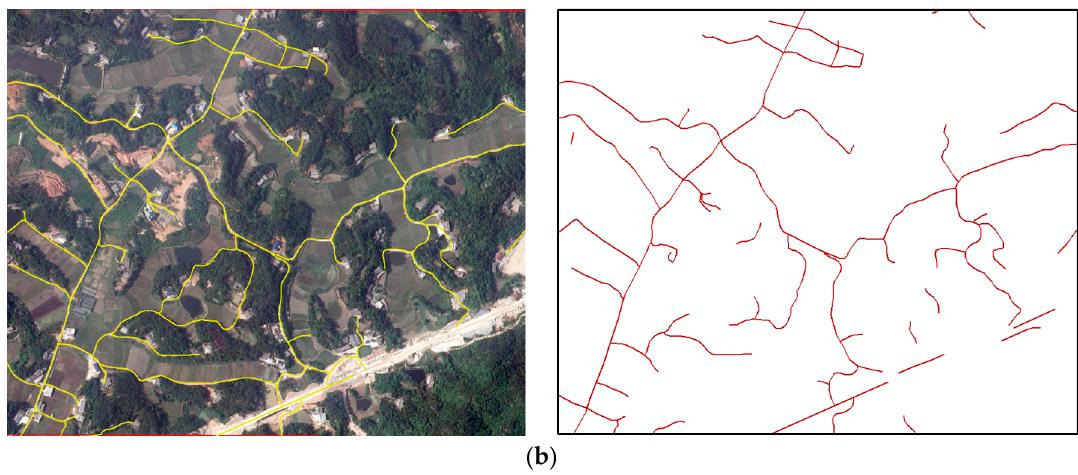
Figure 13. Comparison between ground truth (left) and extraction result (right): ( a ) Region A; ( b ) Region B.